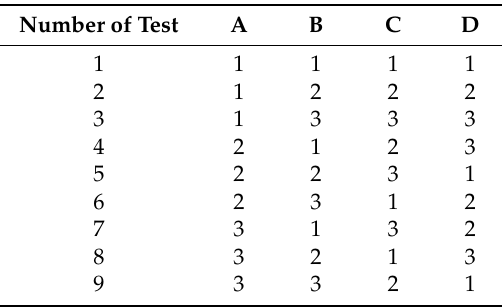
Table 9. Taguchi L 9 (3 4 ) standard orthogonal